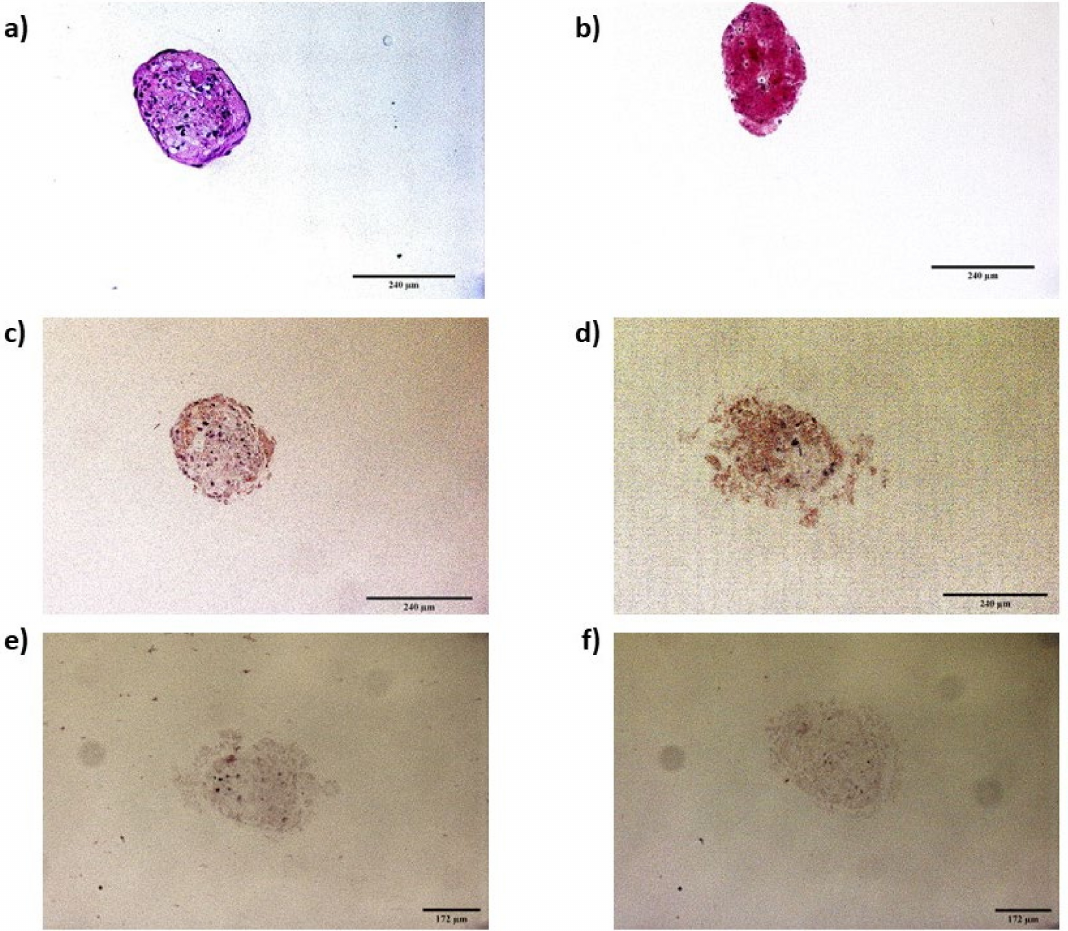
Figure 8. Hematoxylin–eosin staining of spheroids in growth ( a ) and neurogenic ( b ) conditions. PrP Sc immunostaining (brown deposits) of scrapie-infected spheroids in growth ( c ) and neurogenic differentiation ( d ) conditions, and their respective background controls with omission of the primary antibody ( e , f